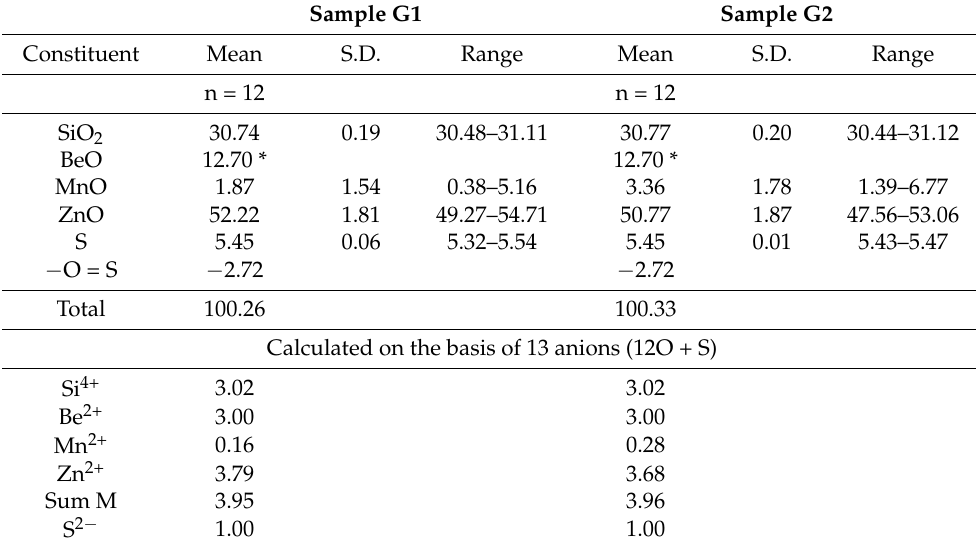
Table 1. Chemical composition (wt.%) of genthelvite Be 3 Zn 4 (SiO 4 ) 3 S.